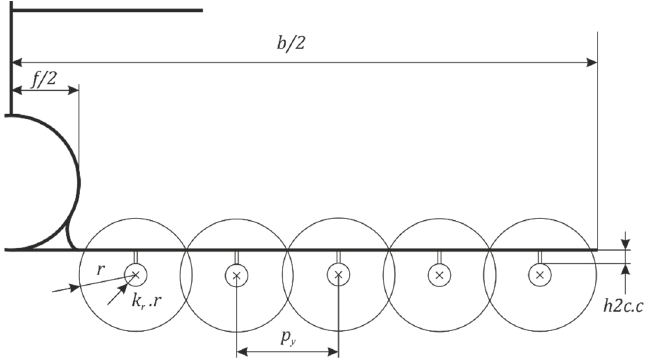
Figure 4. Front view of the geometric layout of the half section of the aircraft with distributed propellers in front of the wing and the main characteristic dimensions.